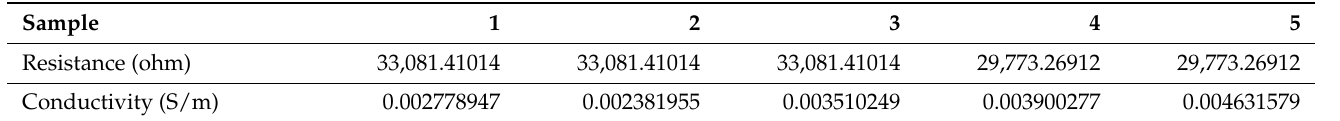
Table A2. Conductivity Data for Nylon 610 Nanocomposites with 1.5 wt% Graphite Nanosheets Treated at 200 ◦ C and − 1 bar.